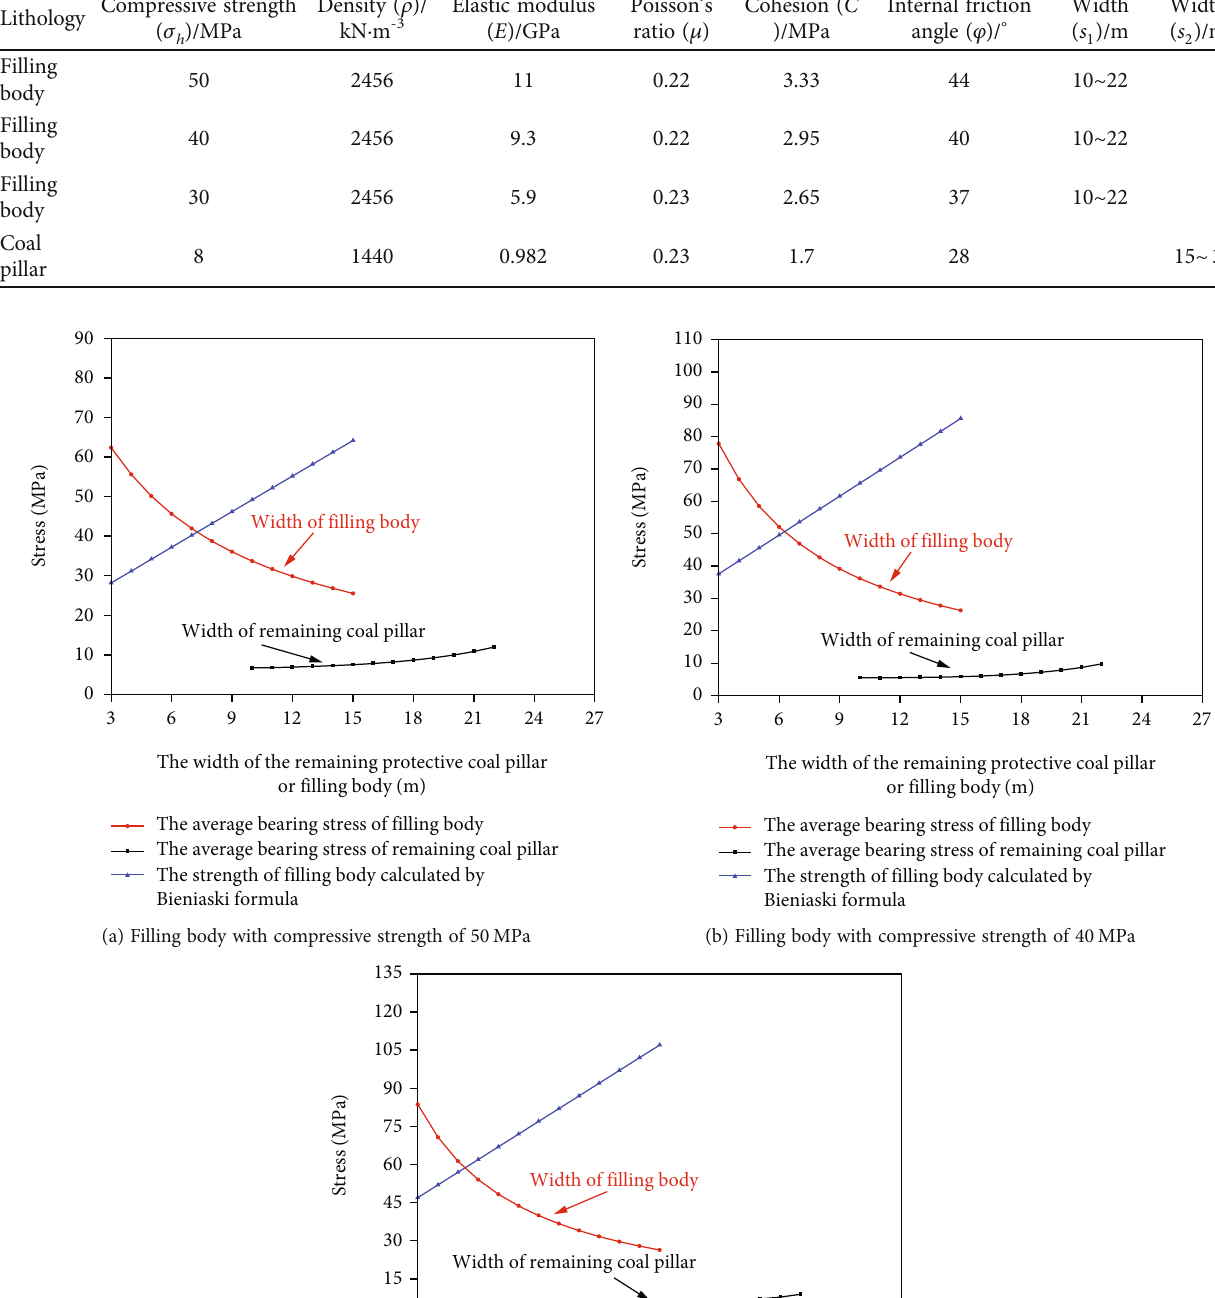
Table 3: Mechanical parameters of the “ fi lling body-remaining coal pillar ” structure.